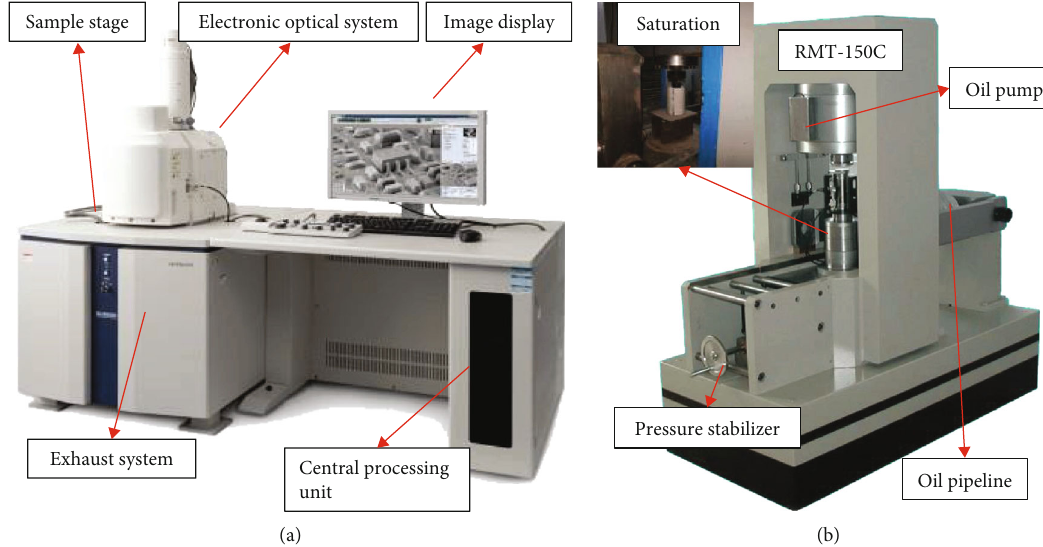
Figure 4: Equipment for tests. (a) SU3500: Hitachi gaoxin SEM. (b) RMT-150C: Rock mechanics test system.